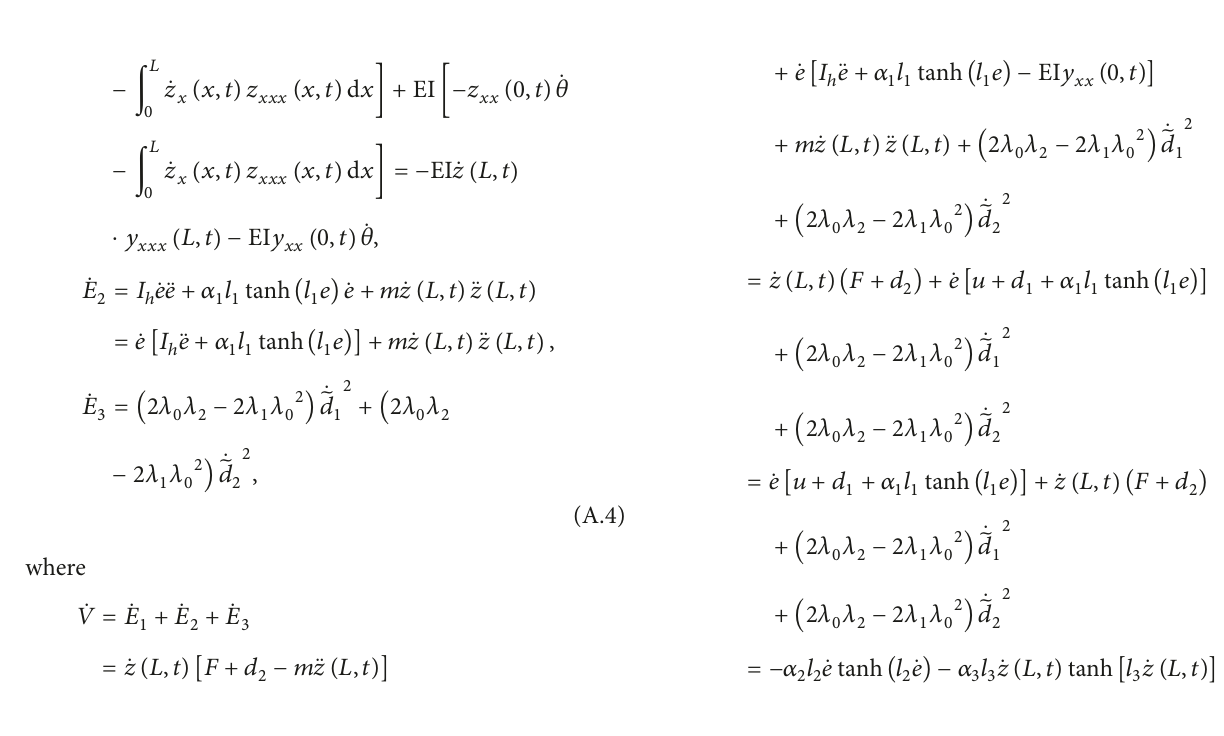
Figure 3: Deflections at the tip and at the middle for (a) the boundary control scheme with the high order observer and (b) the control scheme employing the constant disturbance